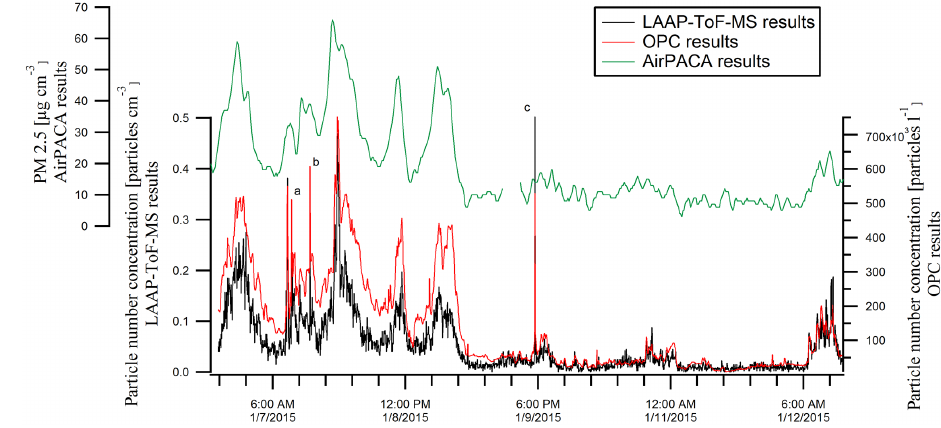
Figure 4. The total particle number concentration detected by LAAP-ToF-MS and OPC as a function of time; indicated are peaks corre- sponding to smoking events ( a and b ) and to generation of TiO 2 (c) . The total PM 2 . 5 results according to Air PACA are depicted in